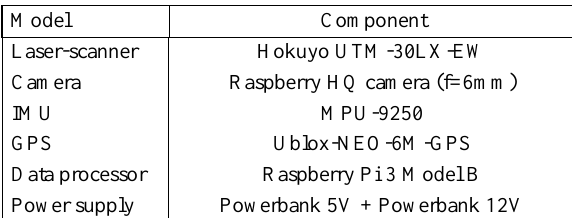
Table 1 . System components